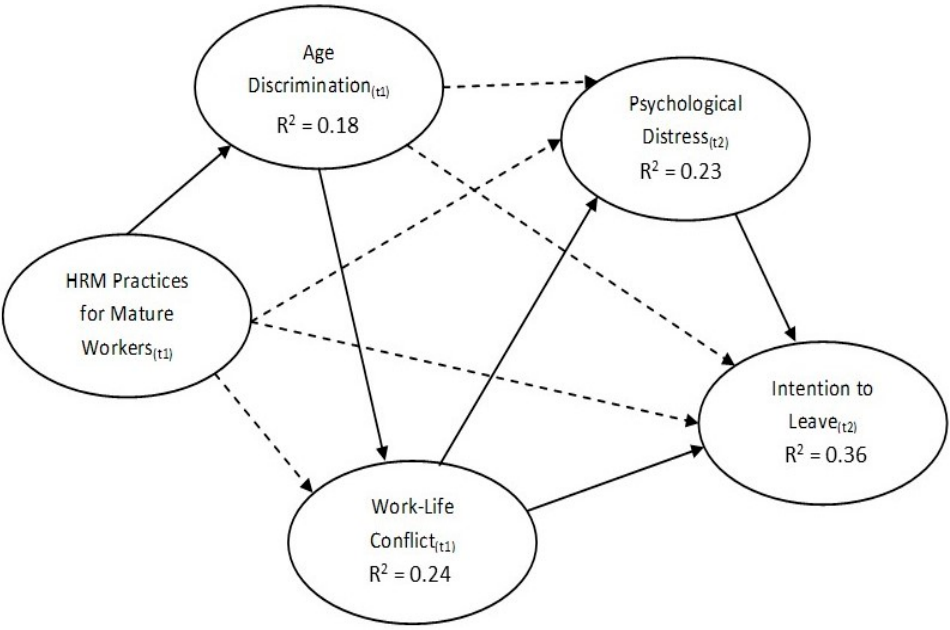
Figure 2. Path model R 2 results. The complete line = significant path; the dotted line = mediation pathway; t1 = the data obtained from the first wave of collection (time 1); and t2 = data obtained from the second wave of collection (time 2).